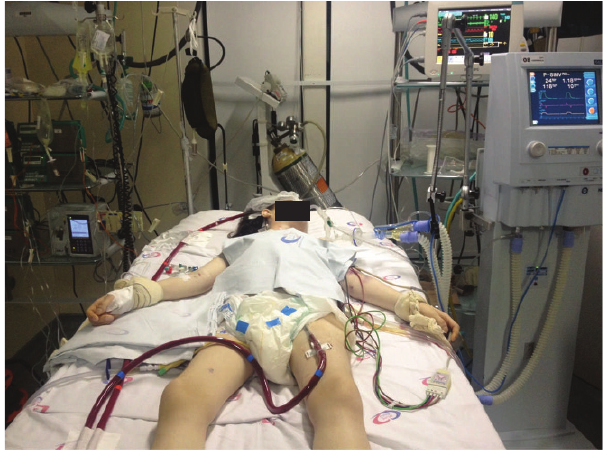
Figure 3 - A patient in intensive care receiving mechanical ventilation and ECMO